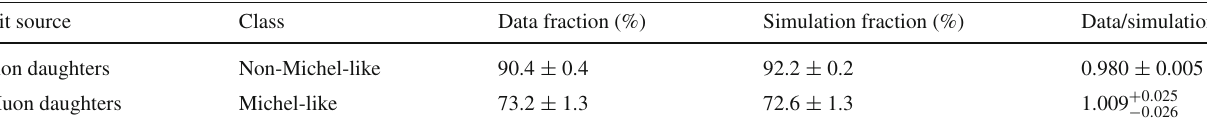
Table 6 Fraction of reconstructed particles classified into appropriate class for different samples in ProtoDUNE-SP data and simulation. The errors represent the statistical uncertainties calculated using the Clopper–Pearson method